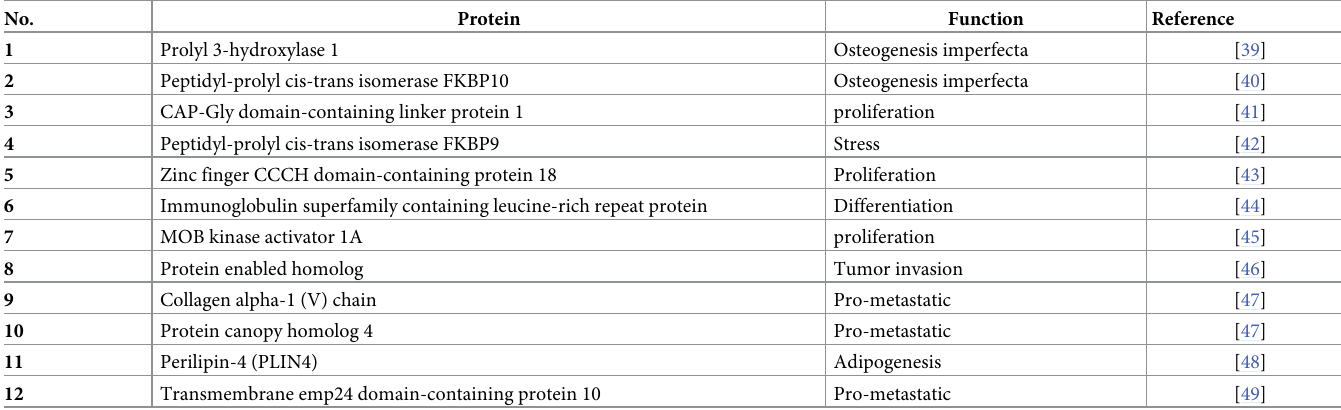
Table 4. List of protein functions identified in stage 2 breast cancer samples. No. Protein